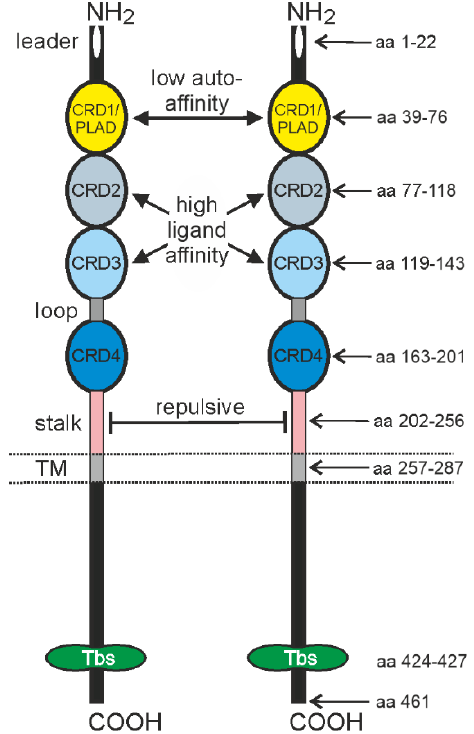
Figure 1. Domain architecture of TNFR2. CRD1–CRD4 of TNFR2 define the affiliation to the TNFRSF. Structurally poorly defined parts of CRD1, designated as pre-ligand binding assembly domain (PLAD), mediate low-affinity TNFR2 self-assembly in the absence of TNF. CRD2 and CRD3 mediate high-affinity binding of TNF while the function of CRD4 is largely unclear. The stalk region has repulsive features and antagonize PLAD action. TRAF2 binding site (Tbs) indicates a short amino acid motif interacting with the C-TRAF domain of a TRAF2 protomer.